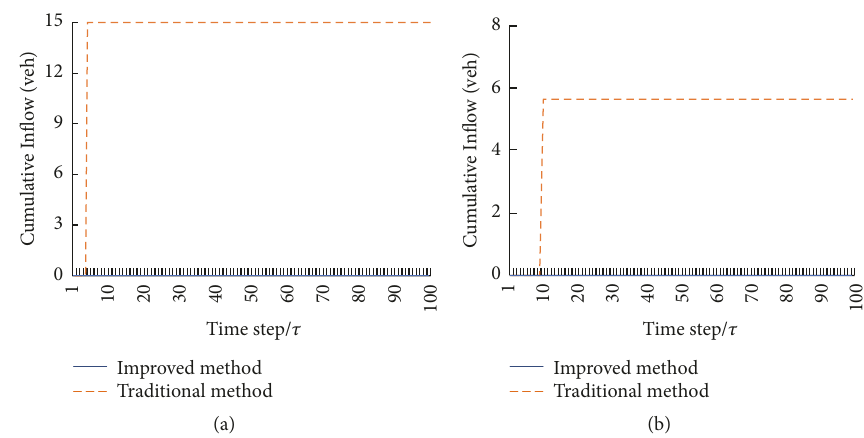
Figure 7: Cumulative vehicles driving into road (5,4): (a) low demand; (b) high demand.